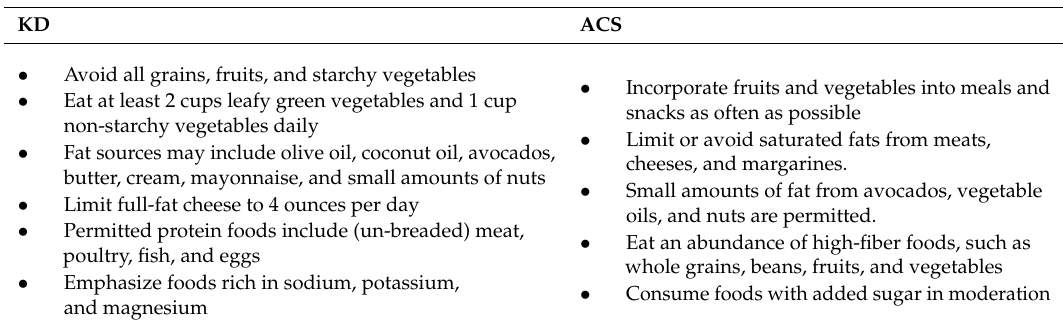
Table 1. Dietary guidelines for